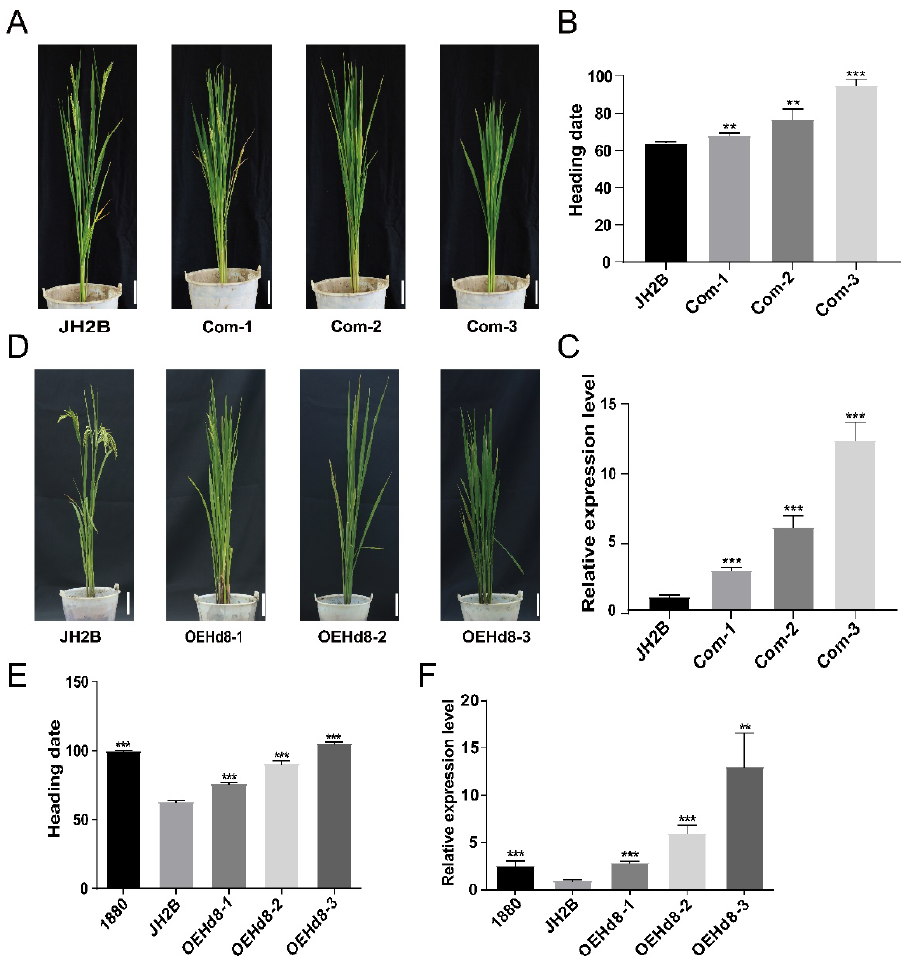
Figure 3. Effect of OsHd8 on heading date in rice. ( A ) and ( D ) Comparison of heading date of JH2B, OsHd8 complemented transgenic plants (Com-1-Com-3) and OsHd8 overexpression transgenic plants (OEHd8-1-OEHd8-3). Scale bars = 5 cm; ( B ) and ( E ) Statistical analysis of heading date of JH2B, OsHd8 complemented transgenic plants and OsHd8 overexpression transgenic plants. Values are means ± SD (n = 5), The asterisks indicate significant differences (**, p < 0.01; ***, p < 0.00; Student’s t-test); ( C ) and ( F ) Expression levels of OsHd8 in the JH2B, OsHd8 complemented transgenic plants and OsHd8 overexpression transgenic plants. Values are means ± SEM (n = 3), The asterisks indicate significant differences (**, p < 0.01; ***, p < 0.00; Student’s t-test). To further validate the function of LOC_Os08g0774 0, an overexpression construct